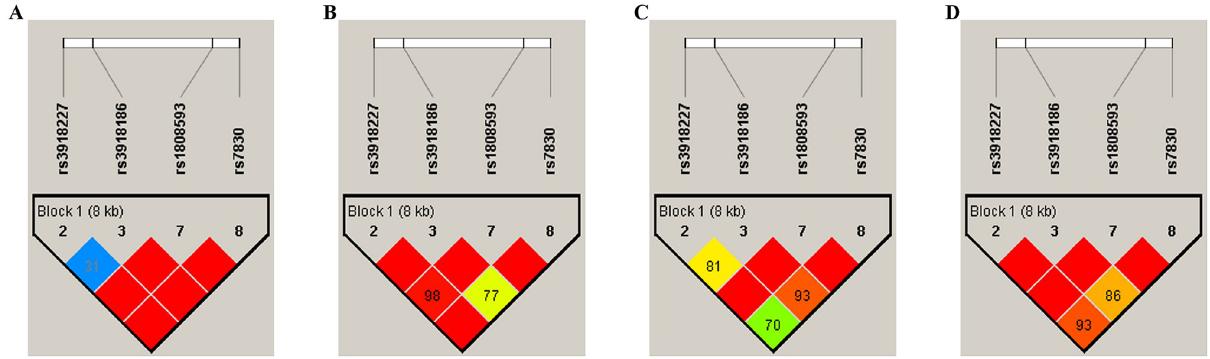
Fig 1. D’ values of the linkage disequilibrium pattern of the NOS3 gene. (A) LD analysis of Guizhou Miao population. (B) LD analysis of Guizhou Buyi population. (C) LD analysis of Guizhou Han population. (D) LD analysis of Guizhou total populations.